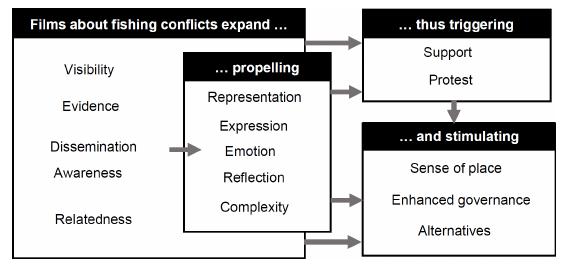
Fig. 4 . Chain effects of using films in fishing